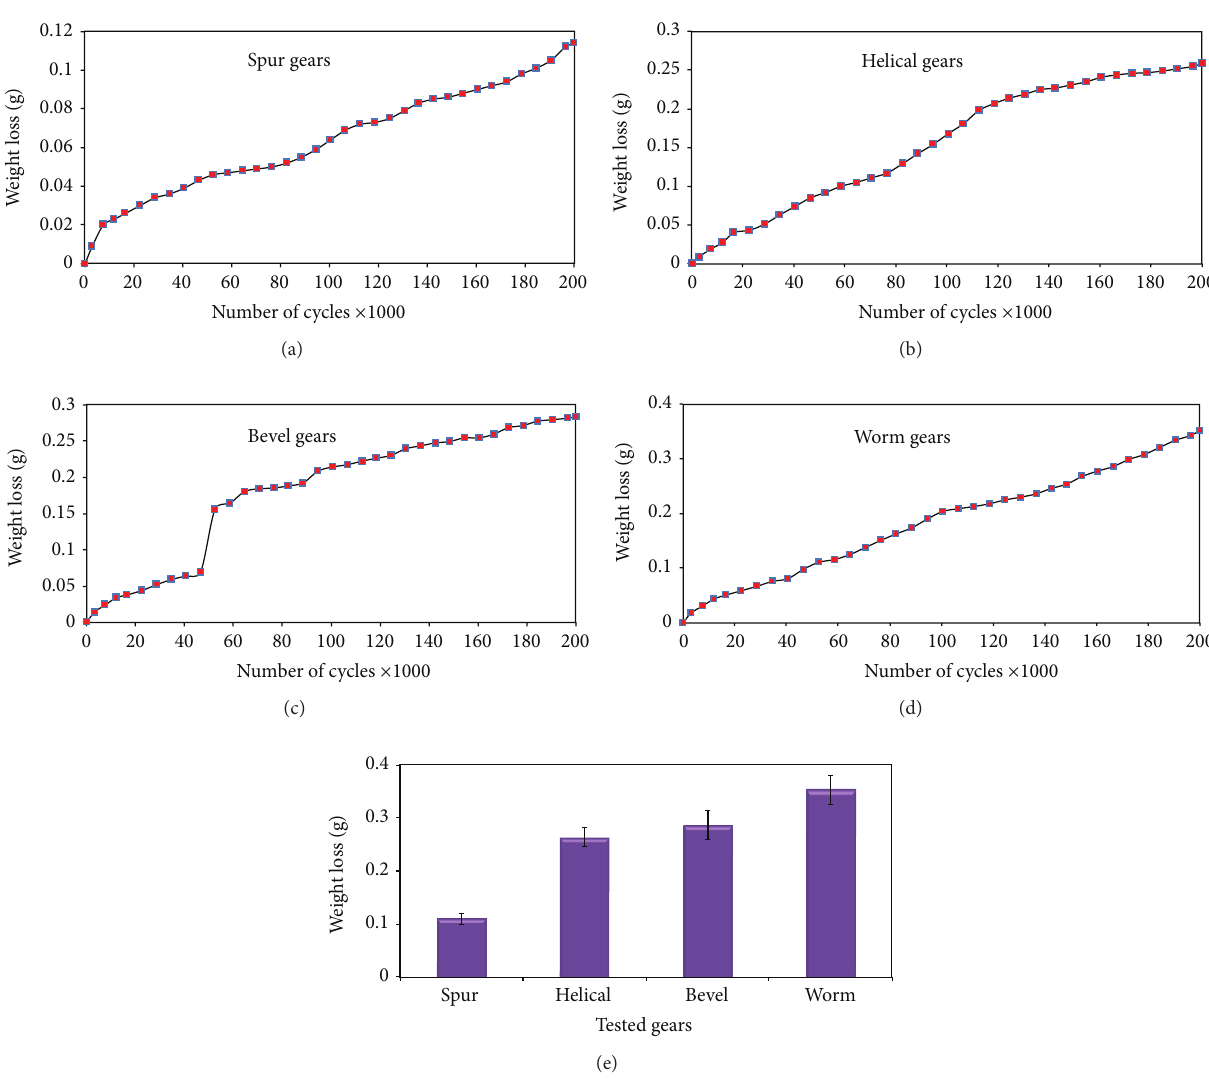
Figure 7: Wear of the (a) acetal spur gears, (b) acetal helical gears, (c) acetal bevel gears, (d) acetal worm gears, and (e) total weight loss for each gear with standard division errors after three-time